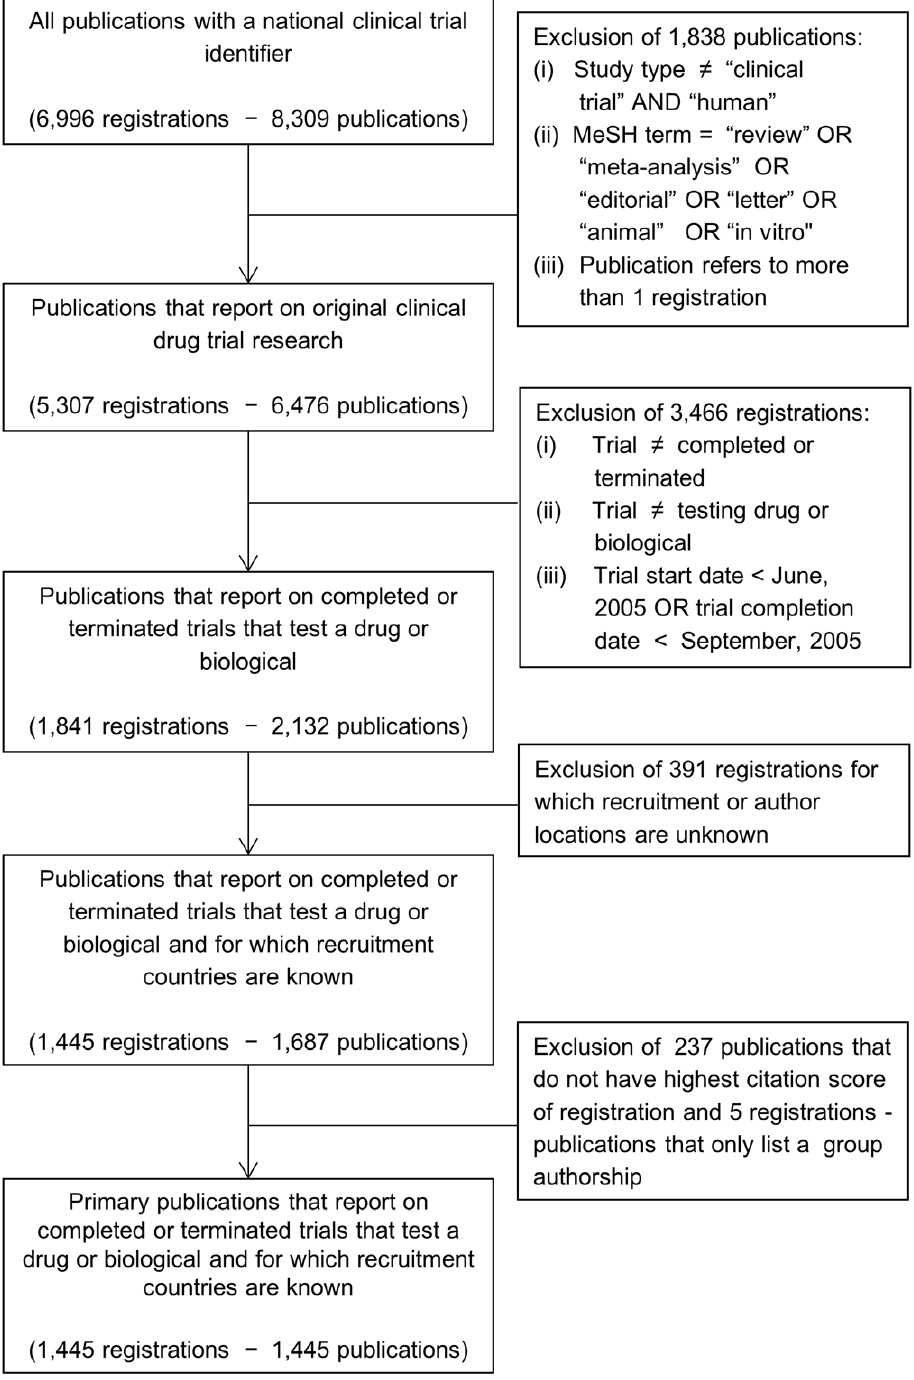
Figure 1. Inclusion flowchart of sample.